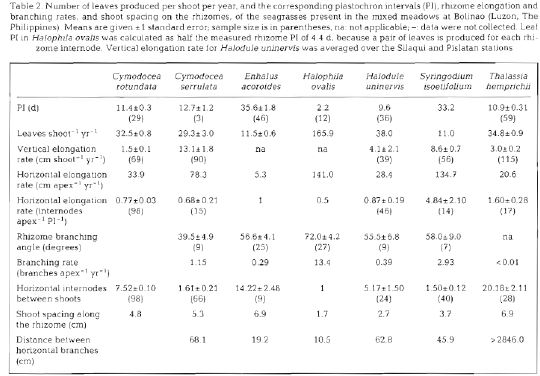
Figure 1. Weight and size of the modules of seagrasses (Vermaat et al., 1995).